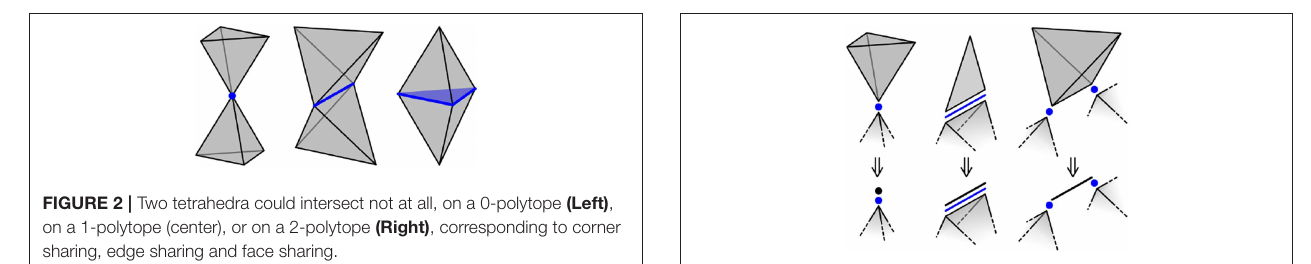
FIGURE 4 | A direct d -polytope can contribute fewer than φ ( d ) degrees of freedom. For a direct 3-polytope connected to a single intersection 0-polytope (left), the two orientational variables do not affect the network’s behavior, and the direct polytope can safely be replaced by a direct 0-polytope. More generally, only the connection of a direct polytope to an intersection polytope affects the network behavior, and the direct polytope can be replaced by the convex hull of the connected intersection